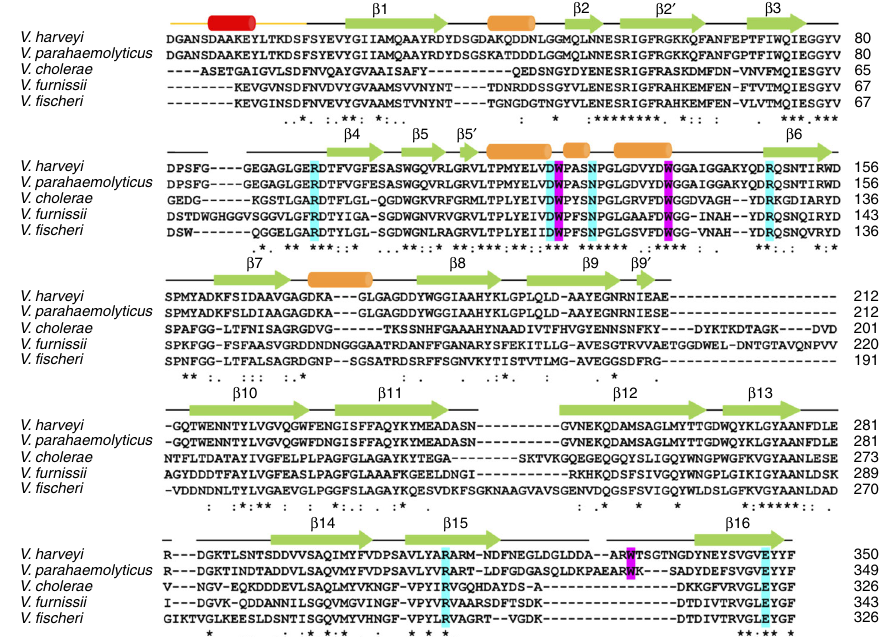
Fig. 5 Alignment of Vh ChiP orthologs from Vibrio species. Observed secondary structure elements have been indicated (orange cylinders, helices; green arrows, β -sheets). The fi rst helix that is part of the N-terminal plug is presented in red. Key aromatic (purple) and hydrophilic residues (cyan) interacting with chitooligosaccharides are colored. The following orthologs have been aligned: V. harveii (GenBank ID: HF558985.1), V. parahaemolyticus (GenBank ID: CPO12950.1), V. cholera (GenBank ID: DQ774012.1), V. furnissii (GenBank ID: AF129934.1), and V. fi scheri (GenBank ID: CP001139.1). Chitoporin from V. harveyi (UniProtKB/TrEMBL entry: L0RVU0) was used as protein template to identify putative chitoporins. The alignment was generated using “ CLUSTALW ” algorithm in the DNASTAR package and displayed in Genedoc. The secondary structure of Vh ChiP was generated by ESPript v. 2.2